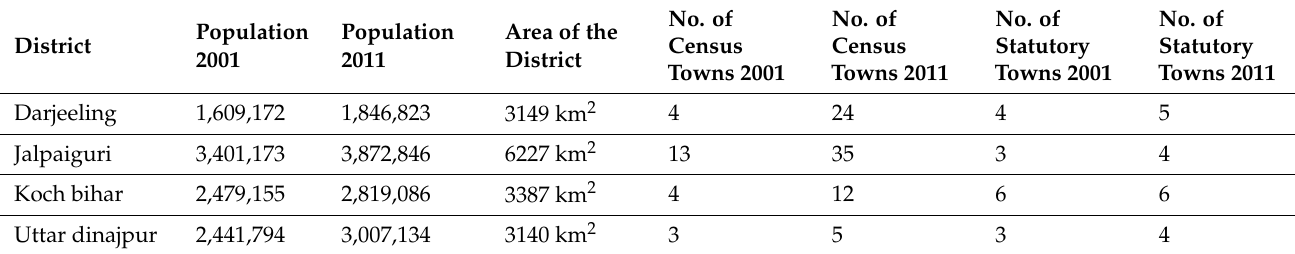
Table 1. Delineated region